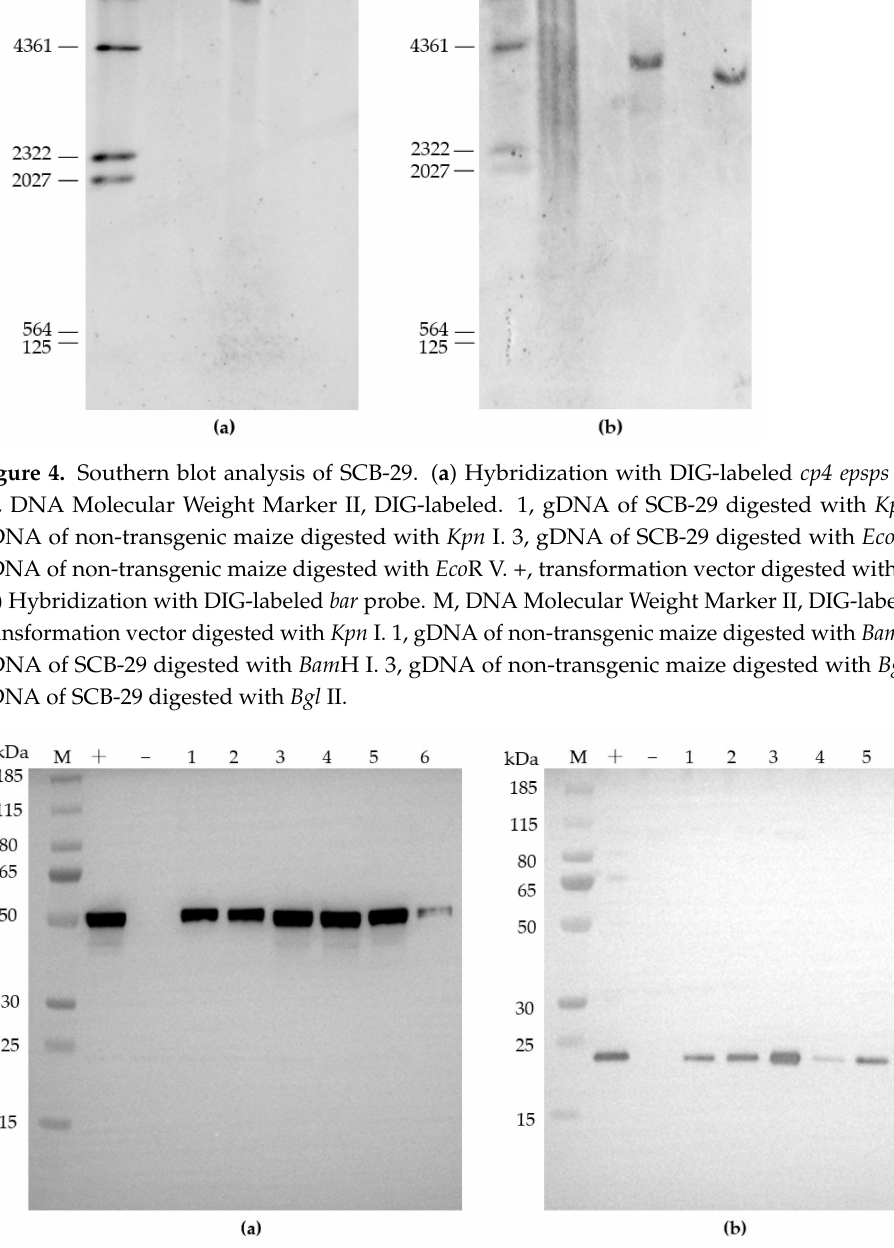
Figure 5. Western blot analysis of CP4 EPSPS and Bar in transgenic maize SCB-29. ( a ) Western blot analysis of CP4 EPSPS in SCB-29. M, PageRuler Plus Prestained Protein Ladder. +, CP4 EPSPS protein expressed in E. coli . − leaf of non-transgenic maize. 1–6, root, stem, leaf, pollen, silk, and seed of SCB-29, respectively. ( b ) Western blot analysis of Bar in SCB-29. M, PageRuler Plus Prestained Protein Ladder. +, Bar protein expressed in E. coli . − , leaf of non-transgenic maize. 1–6, root, stem, leaf, pollen, silk, and seed of SCB-29,